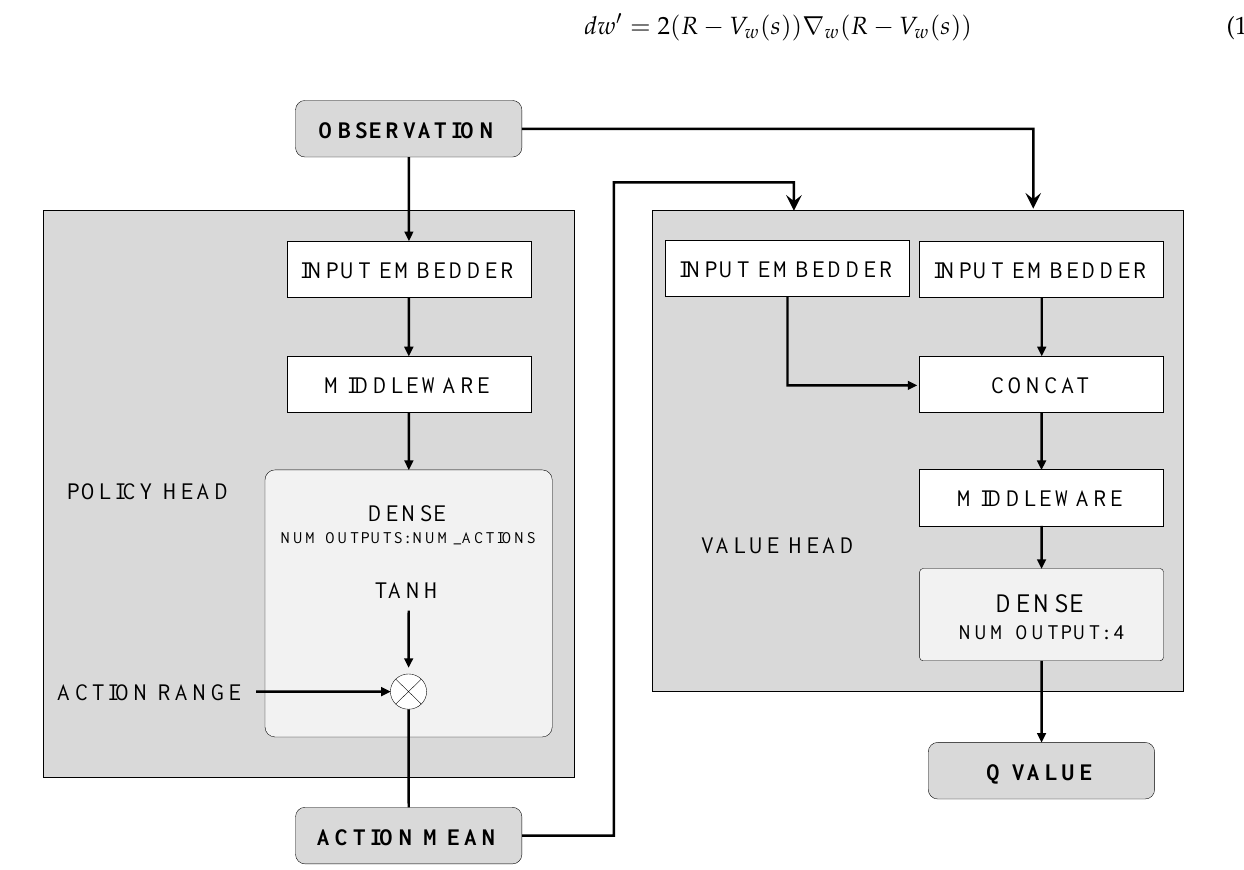
Figure 4. Deep Deterministic Policy Gradient (DDPG) block diagram.